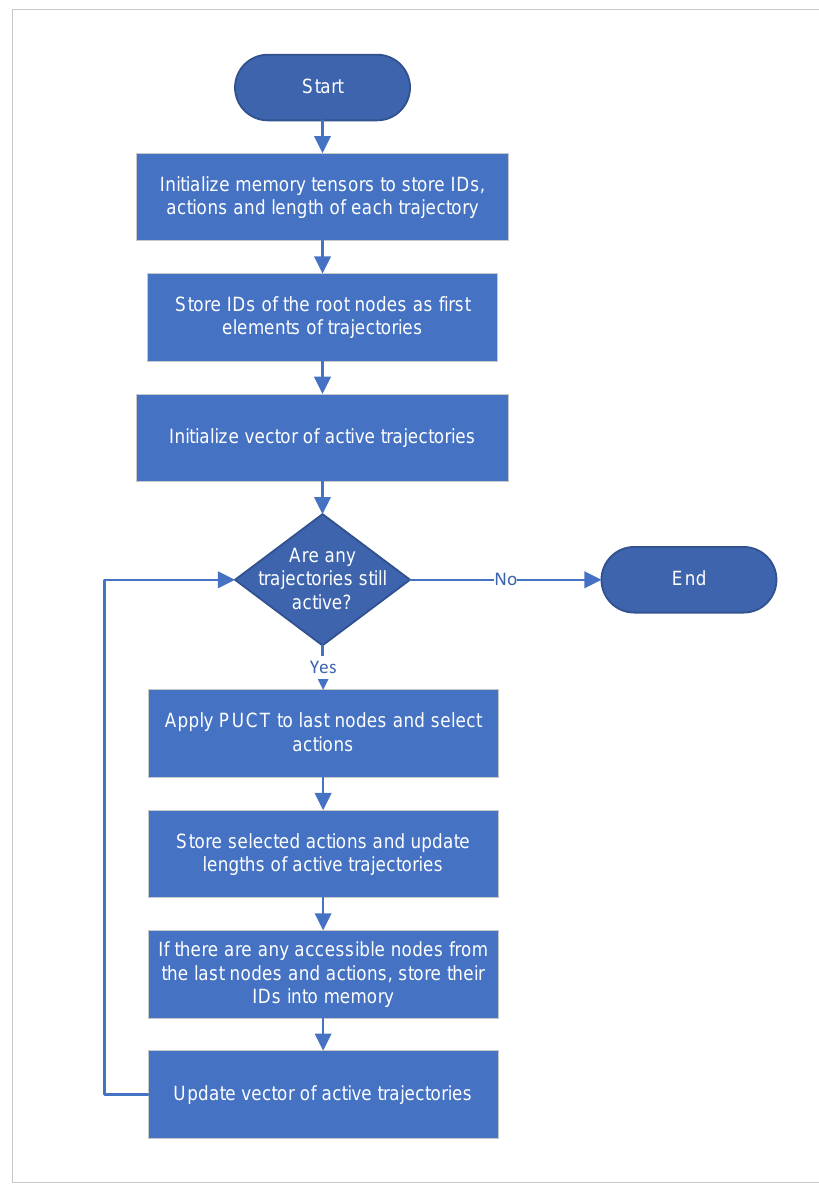
Figure 2. Flowchart of the phase of